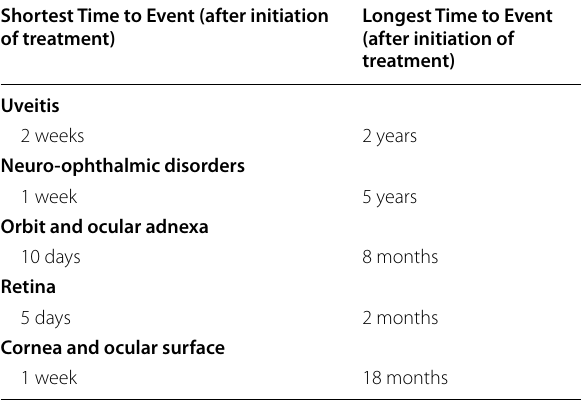
Table 4 Time to onset of the different adverse events Shortest Time to Event (after initiation of treatment)